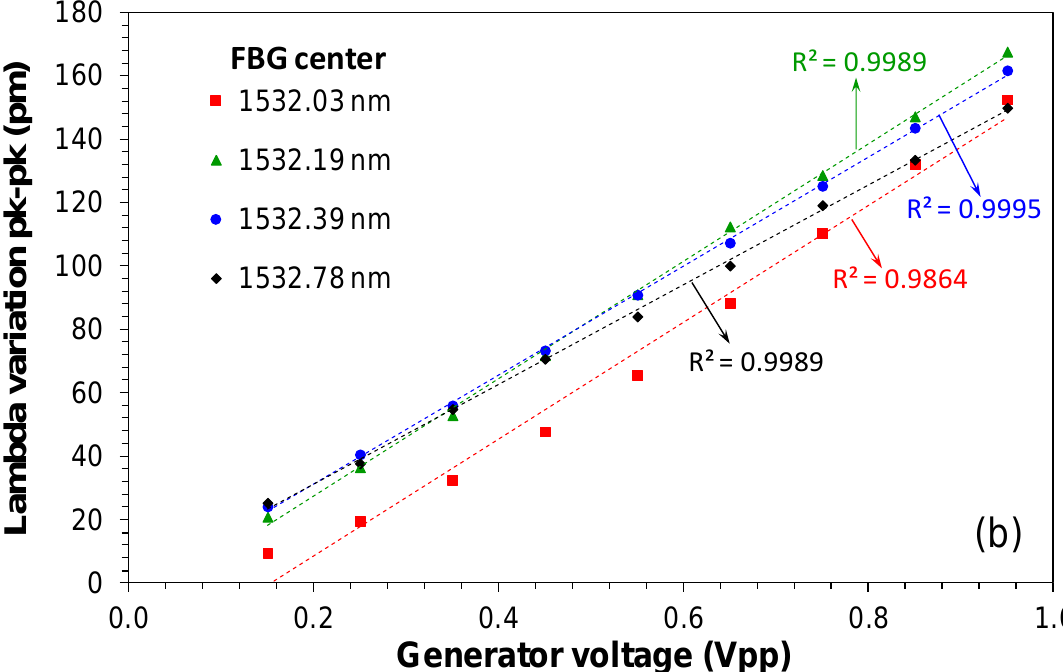
Figure 7. Signal linearity measured in four FBG center wavelengths, ( a ) measured in the demodulator output (E point) and ( b ) measured by a commercial FBG interrogator.